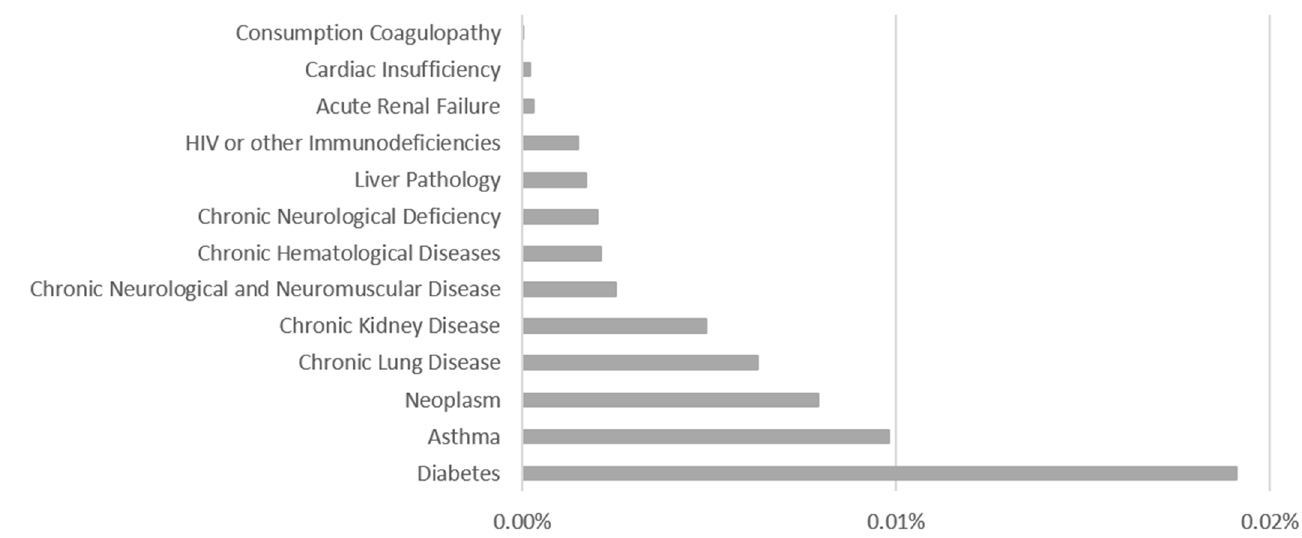
Figure 3. Comorbidities Distribution.